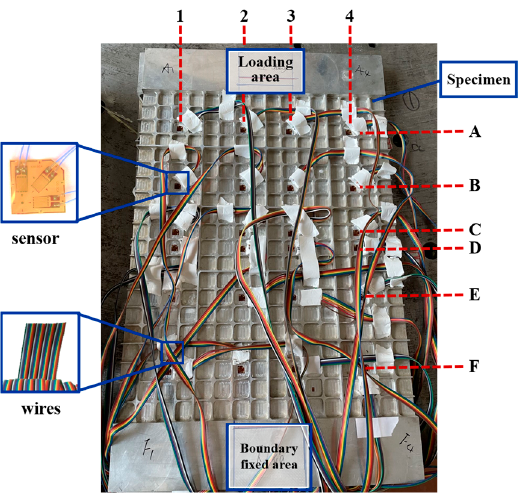
Figure 6. Layout of the sensors on the hierarchical stiffened plate.